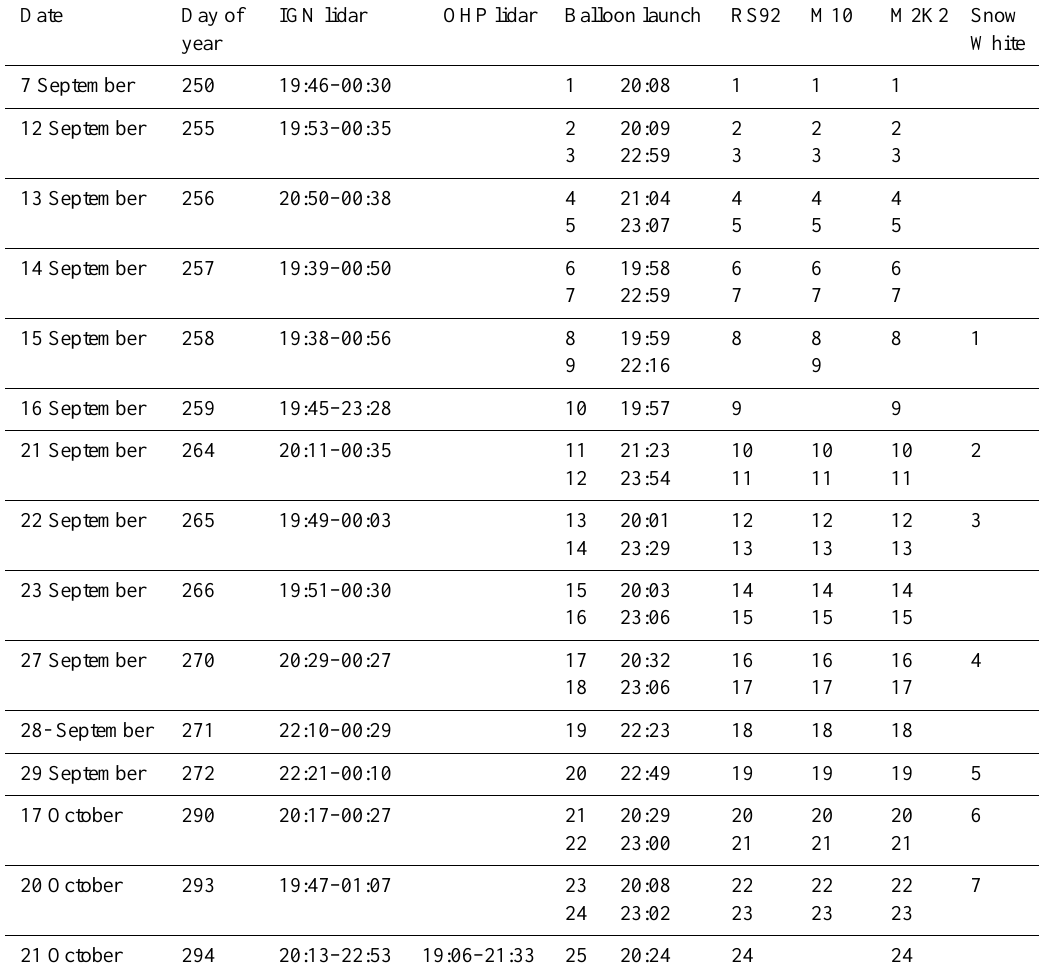
Table 1. Summary of the lidar and radiosonde operations during DEMEVAP 2011